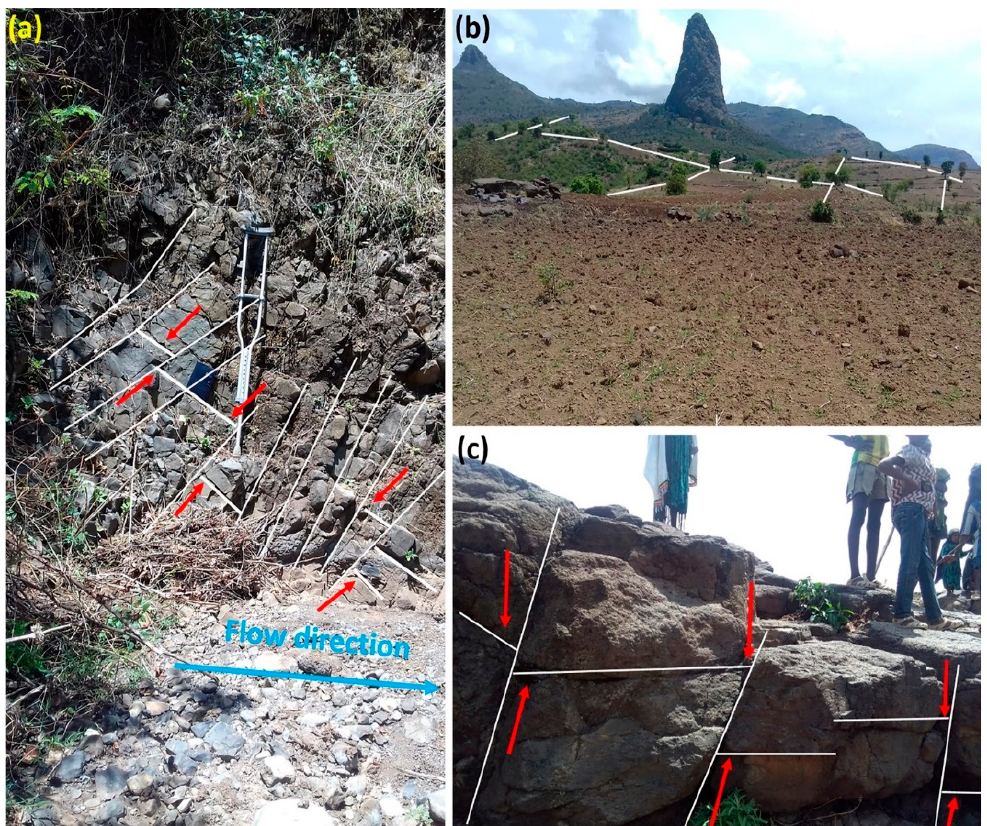
Figure 6. Images showing ( a ) the intersection of the stream channel with jointed and faulted basaltic units trending in the northwest direction in the forested watershed. The dip angle of the fault plane (white lines) is opposite the hillslope and the stream flow direction; ( b ) Acacia trees that grow along Figure 6. Specifically, we noted that the fine-grained aphanitic basalt outcrops in the northeastern part of the watershed ( a ) were intersected by joints and faults. The basaltic unit was tilting and jointed and had a thickness ranging from 1.5 to 2 m. It was highly fractured with a WNW dipping direction. In addition, during the field visit, we identified small scale faults with minor displacement on the dark gray and aphanitic basalt with the major strike direction in an NW-SE direction ( c ). The spring identified above was associated with these minor faults. Finally, our field visits noted that deep-rooted acacia trees were associated with the faults ( b ). We also found, in addition to the major trachyte plug, several smaller plugs on the northern part of the Gomit watershed ( b ). Talus deposits that cover the plugs have large open pore spaces that facilitate the flow of water to the fissures.